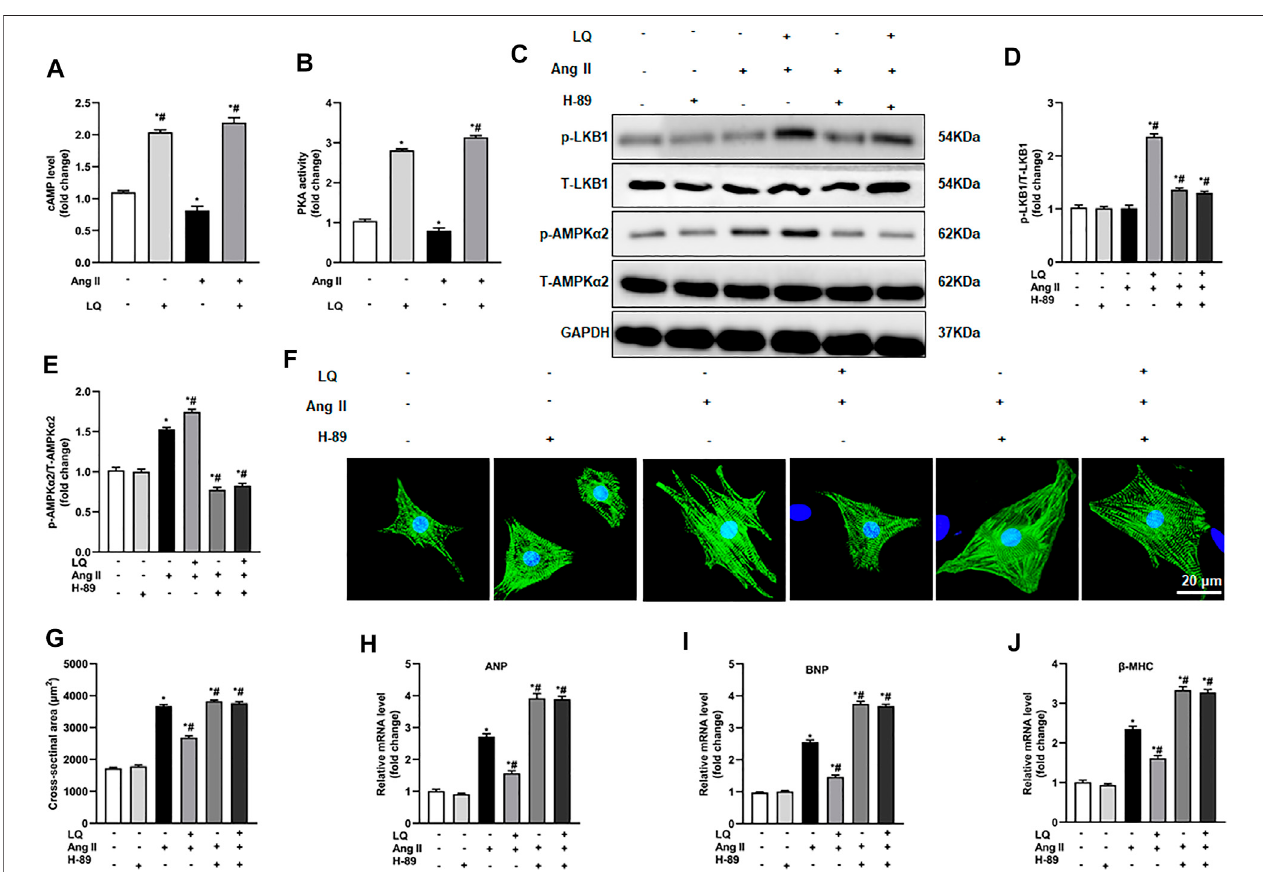
FIGURE 9 | Liquiritin-induced LKB1 phosphorylation is abrogated by PKA inhibition. (A) Quanti fi cation of cAMP levels in the soluble fraction of NRCM homogenates ( n = 6). (B) Quanti fi cation of PKA activity in the soluble fraction of NRCM homogenates ( n = 6). (C) Representative immunoblots for p-LKB1, T-LKB1, p-AMPK α 2, and T-AMPK α 2. Relative expression levels of (D) p-LKB1/T-LKB1 and (E) p-AMPK α 2/T-AMPK α 2 ( n = 6). (F) Representative images of α -actinin immuno fl uorescence (green) in NRCMs. Nuclei were stained with DAPI (blue). (G) CSA estimations based on α -actinin immuno fl uorescence ( n = 6 replicates per group).RelativemRNAexpressionlevelsof (H) ANP, (I) BNP,and (J) β -MHC( n =6).All invitro experimentswererepeatedthreetimesindependently.Dataarepresented asthemean±SEM.One-wayANOVAwasperformedtoexaminestatisticaldifferencesamongdifferentgroups.* p < 0.05vs.thecorrespondingPBS+Vehgroup;# p < 0.05 vs. Ang II +